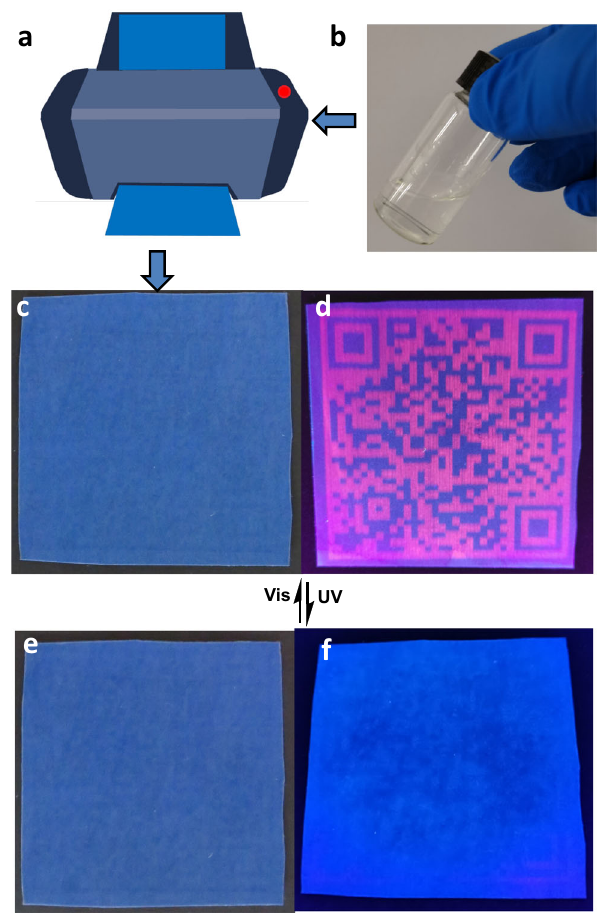
Fig. 5 Pattern printing using SCP as the ink. a , b Schematic illustration of the pattern printing process. Light triggered QR code with visible/invisible transformation behavior was achieved by using supramolecular coordination polyelectrolyte (SCP) as the smart ink. c – f Digital photos of SCP-based luminescent QR code on commercial blue PET fi lm (size: 5 × 5 cm) upon alternating UV (300 nm, 60 s) and visible light (>450 nm, 120 s) irradiation. c , d Photos under daylight. e , f Photos under 254 nm UV